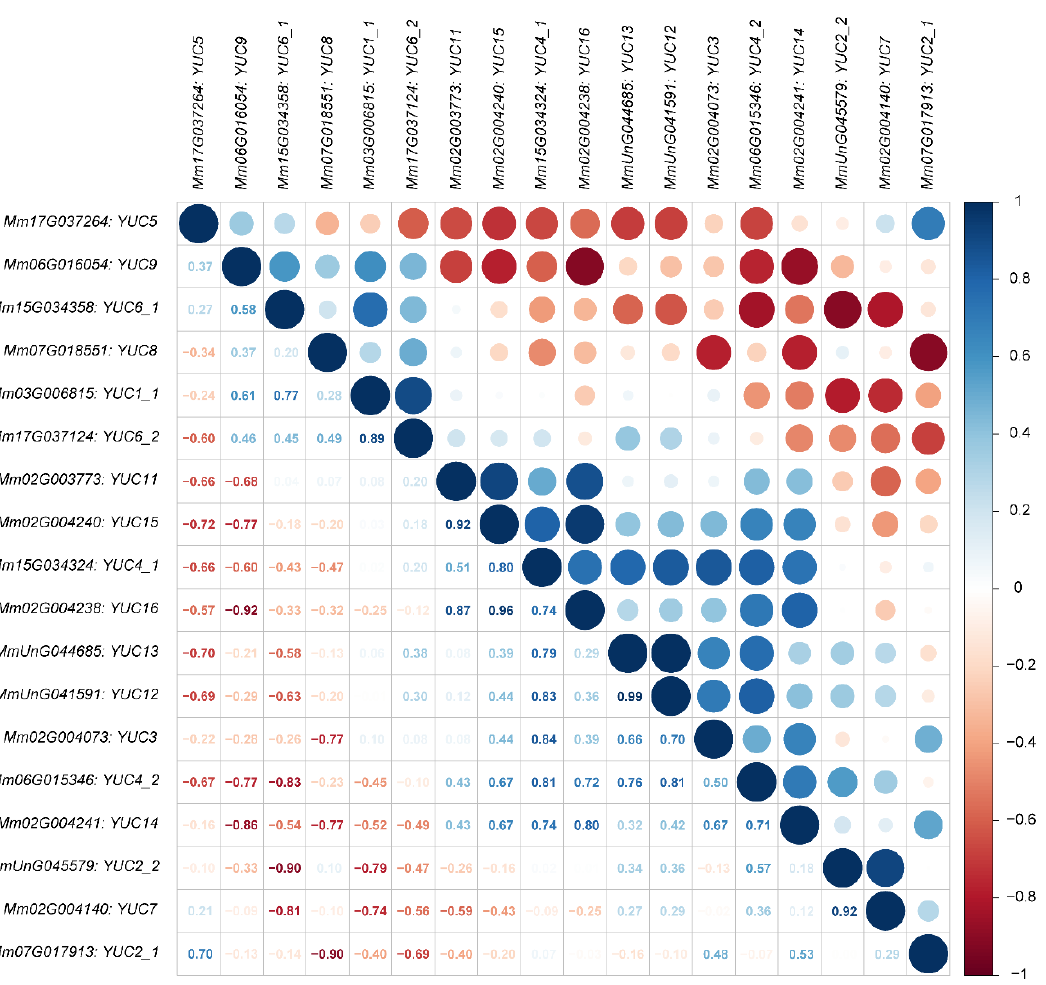
Figure 4. The correlation of gene expression patterns between every two MmYUC genes. Red color and blue color represent negative and positive correlation, respectively.